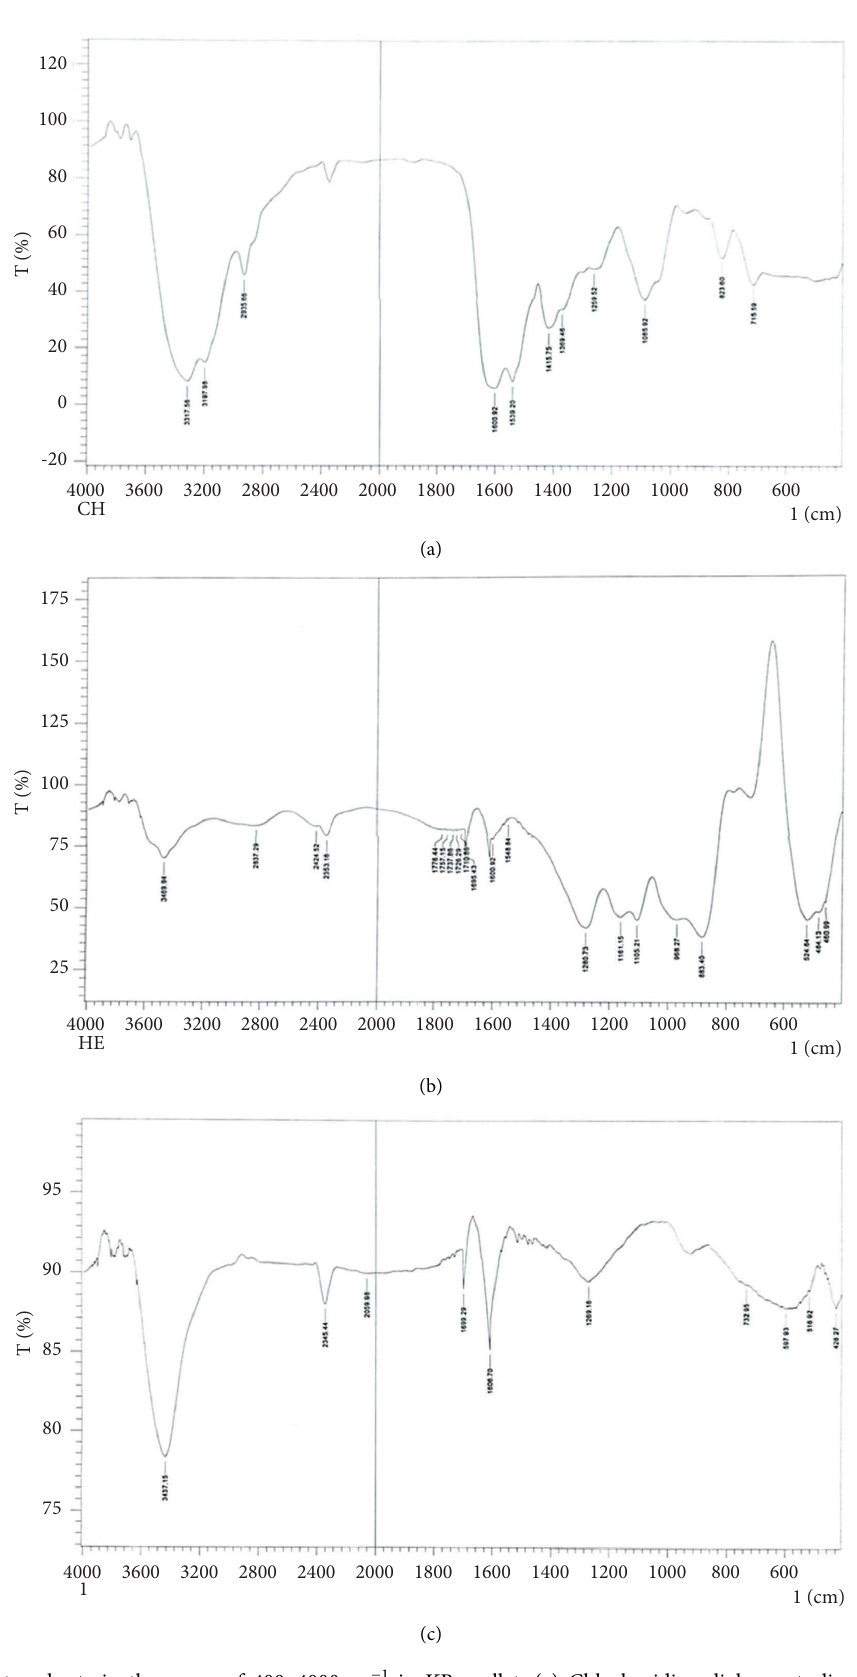
Figure 4: FTIR spectra charts in the range of 400–4000cm − 1 in KBr pellet. (a) Chlorhexidine digluconate liquid. (b) Sodium HMP crystalline powder. (c) Chlorhexidine HMP colloidal suspension nanoparticles after